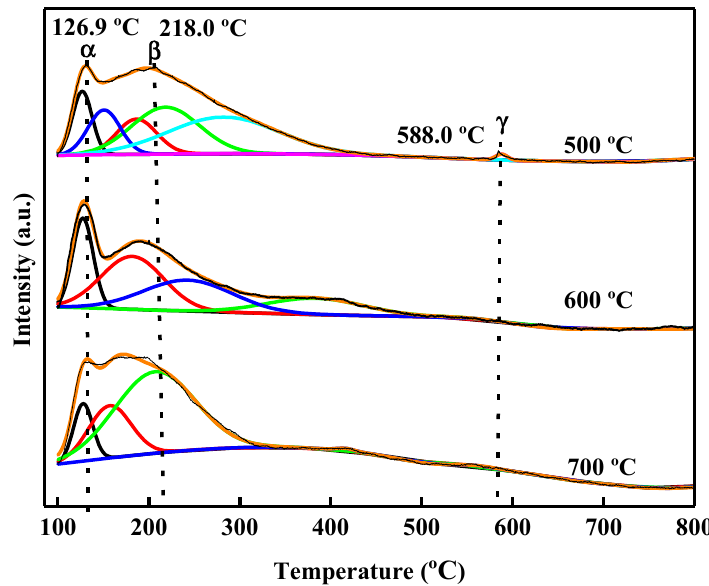
Figure 3. NH 3 -TPD diagram of MoZr. Table 2. Acid properties of the MoO 3 /ZrO 2 catalyst.